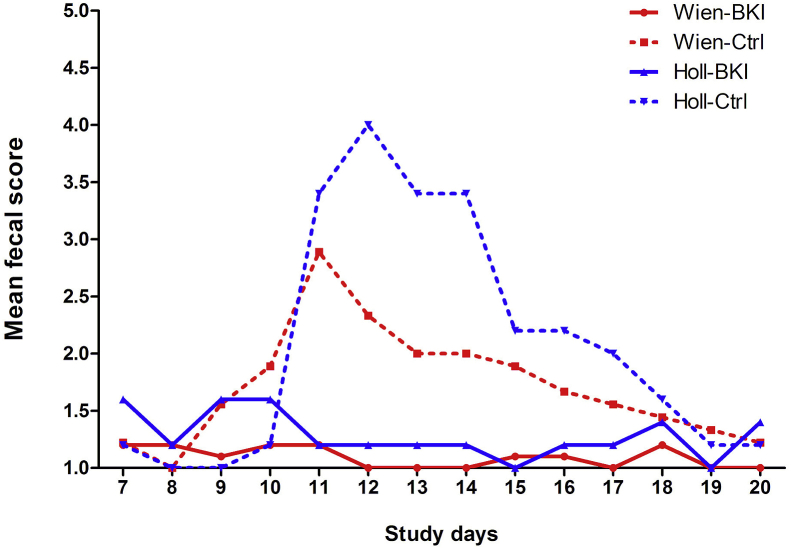
Mean fecal scores of piglets throughout the sampling period of 14 days.